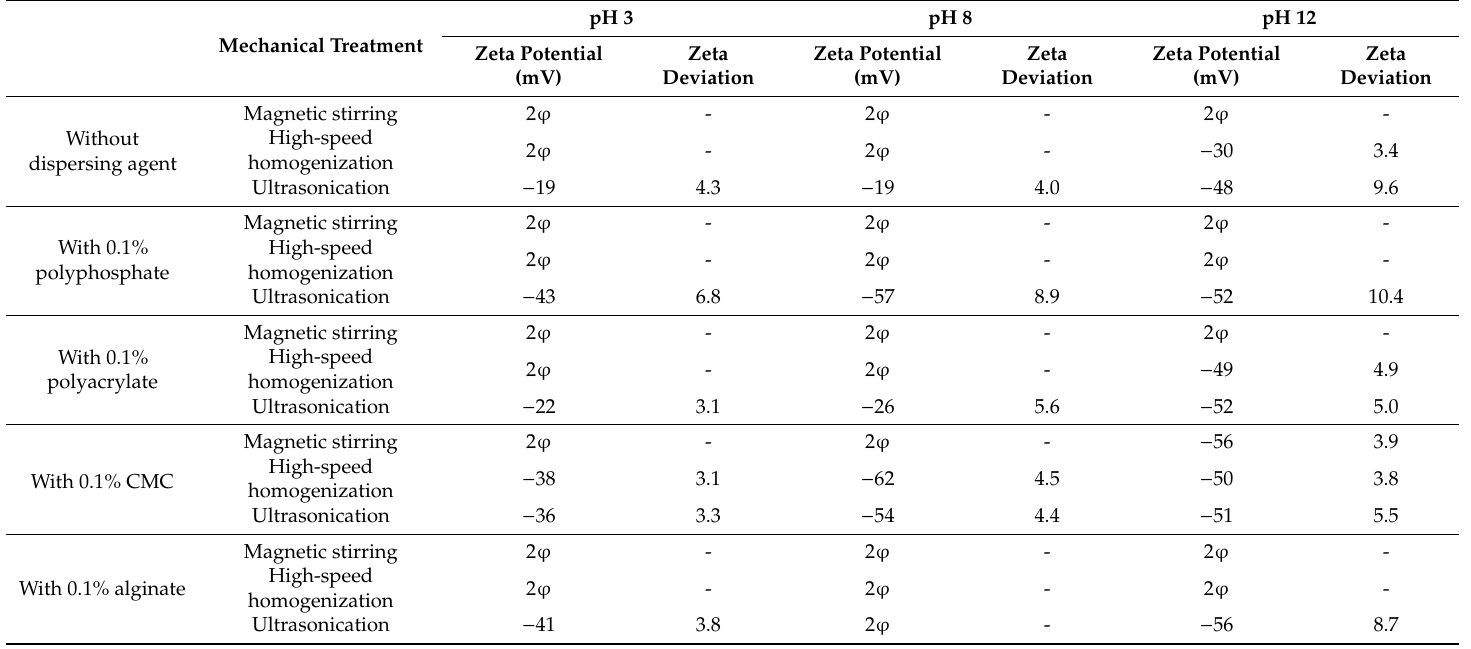
Table A1. Zeta potential values for sepiolite 1 suspensions as a function of the di ff erent conditions